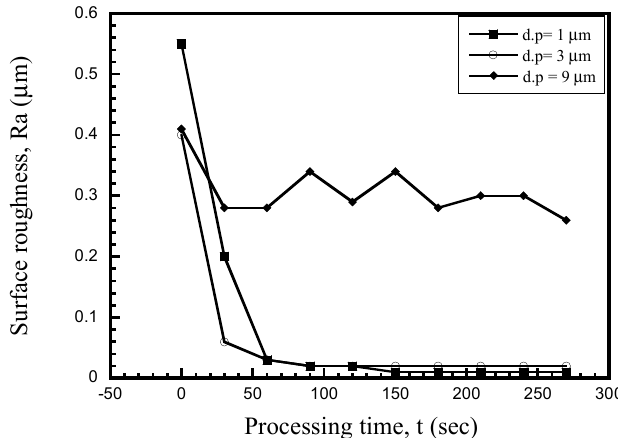
Figure 3. Variations of surface roughness ( R a) against processing time. (spindle revolution: 30,000 rpm, diamond paste weight: 200 mg, frequency of magnetic poles: 12 Hz).